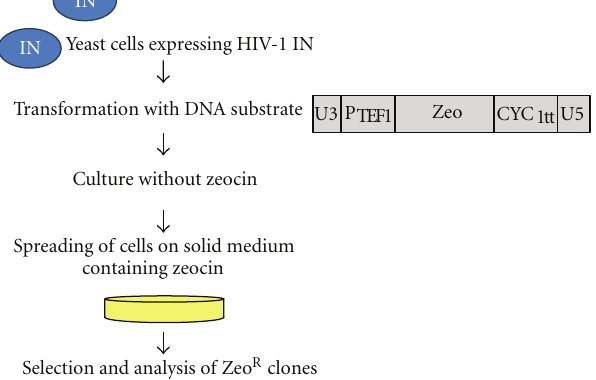
Figure 6: Integration assay in yeast. Adapted from